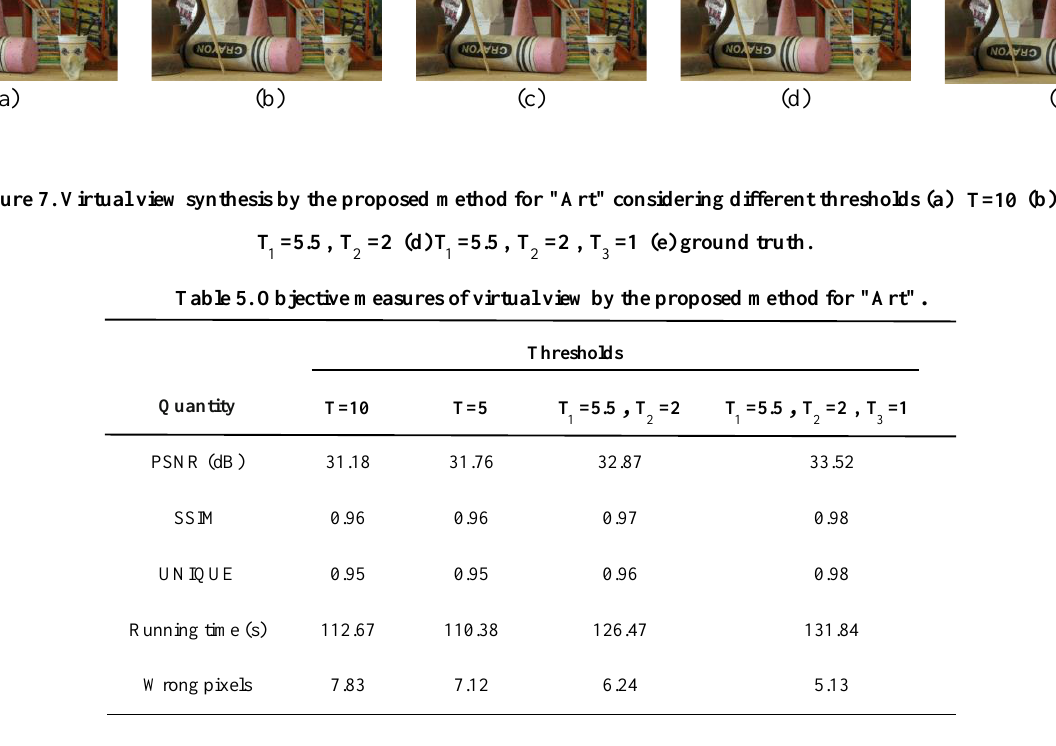
Table 4. Reliable depth map quality for "Art" considering different thresholds. Different thresholds Image quality